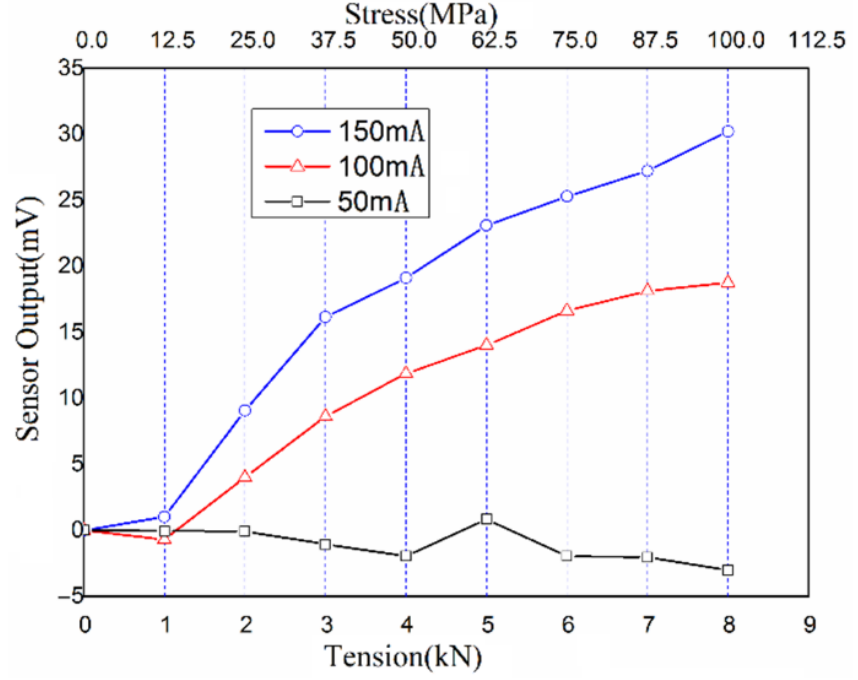
Figure 7. Sense signal curve with stress variation on qualitative measurement.